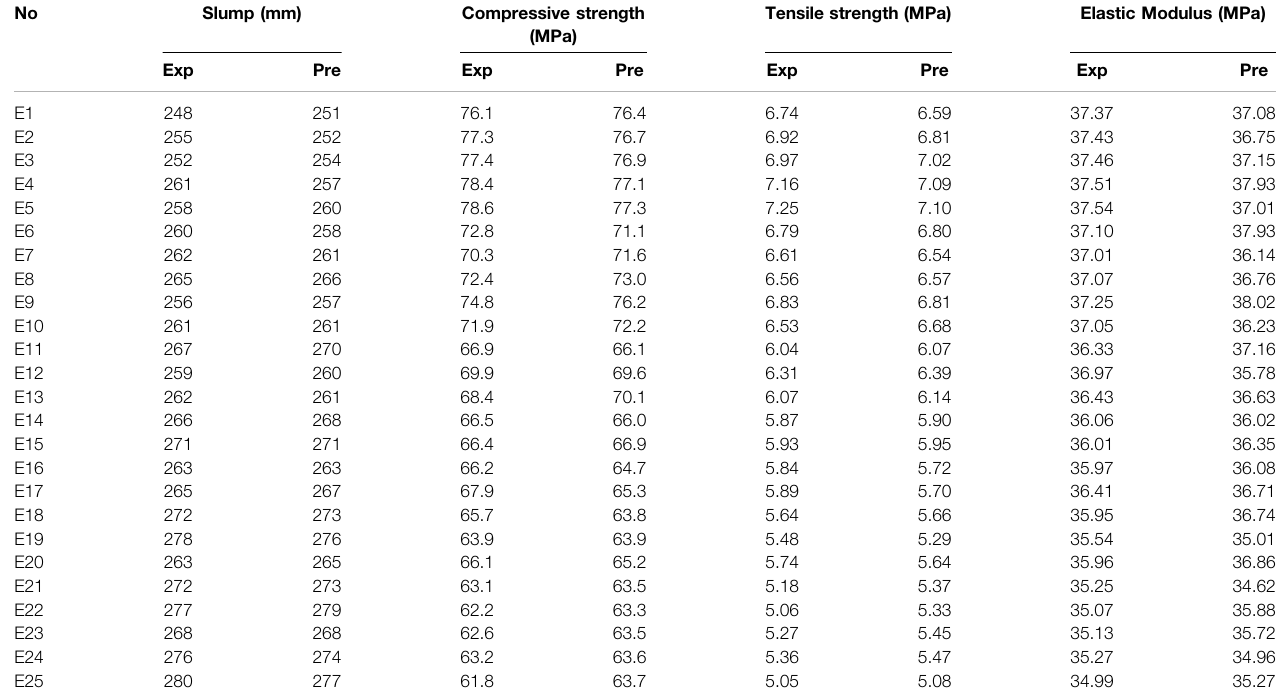
TABLE 3 | Concrete performance test results and ANN prediction results. No Slump